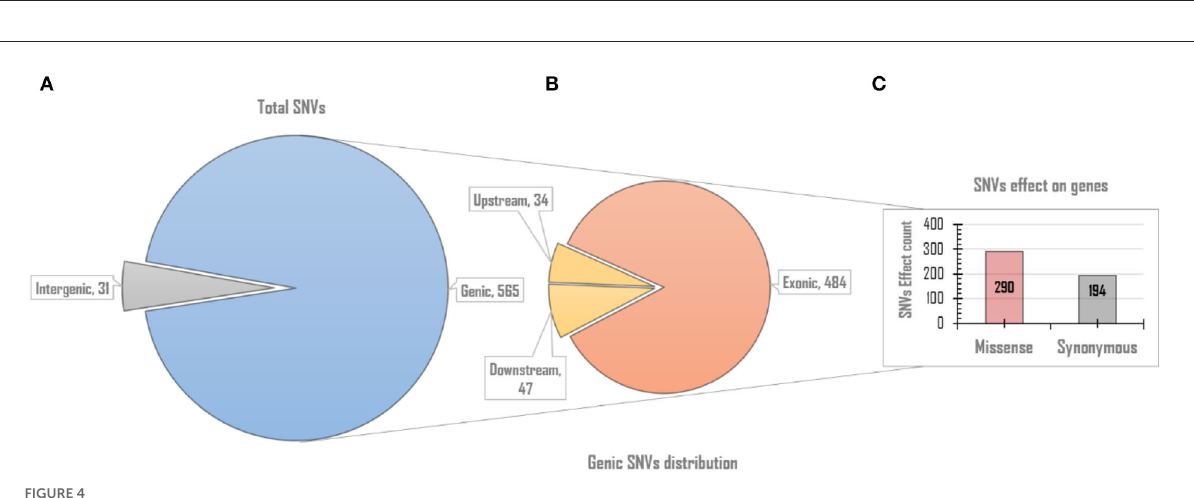
FIGURE4 The overall genomic and functional effect-based distribution of all identified rcntSNV-effects (rcntEffs). (A) Displays the distribution of all predicted rcntEffs into coding/genic and non-coding/intergenic regions. (B) Upon further in-depth annotation, the genic region rcntEffs are distributed among protein-coding (exons) and gene-regulatory (up/downstream) regions of all SARS-CoV-2 genes, whereas the bar chart (C) represents the total missense and synonymous functional effects counts exhibited by all identified rcntEffs found segregating in the gene’s exonic